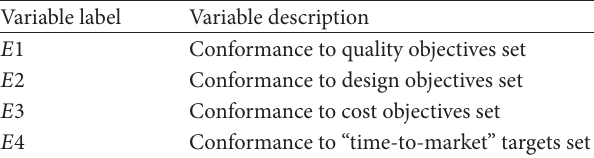
Table 2: The variables manifesting project performance. Variable